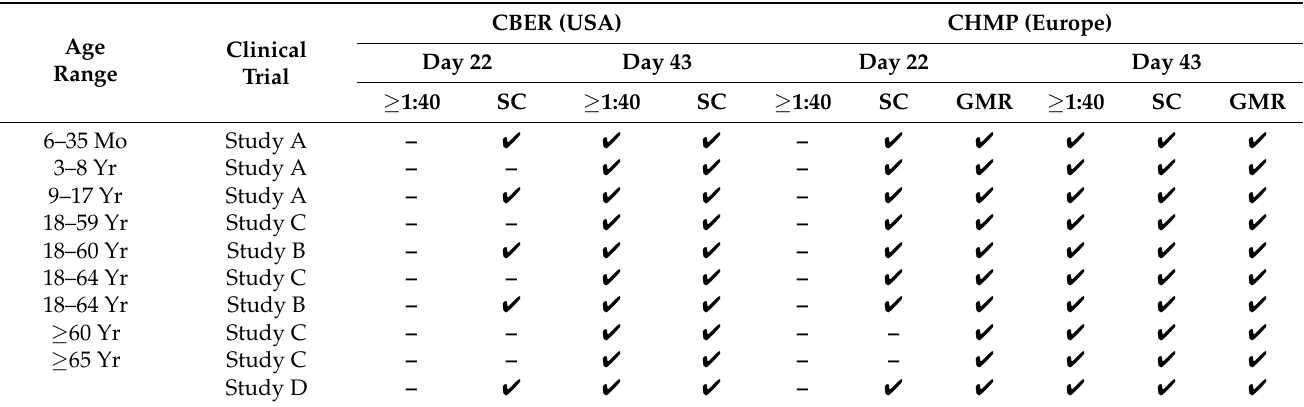
Table 4. Overview of influenza vaccines licensure criteria met in response to full-dose formulation, as assessed by hemagglutination inhibition assay three weeks after first dose (Day 22), and three weeks after second dose (Day 43) administration.